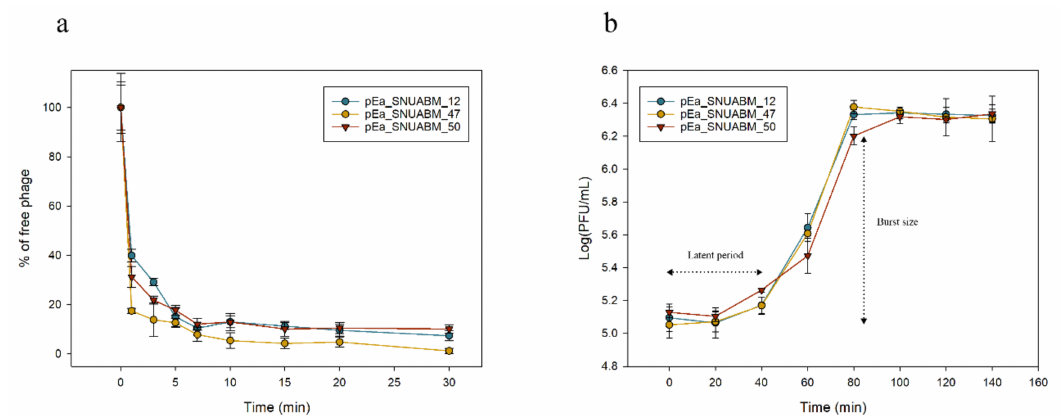
Figure 7. Adsorption ( a ) and one-step growth curve ( b ) of pEa_SNUABM_12, pEa_SNUABM_47, and